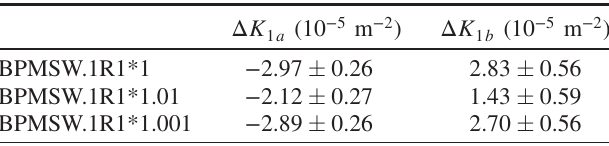
TABLE V. Triplet-by-triplet corrector strengths for the left triplet of IR1 obtained from experimental LHC data. The quadrupoles used as correctors are Q2L ( a ) and Q3L ( b ). The effect of gain errors in BPMSW.1R1 is also